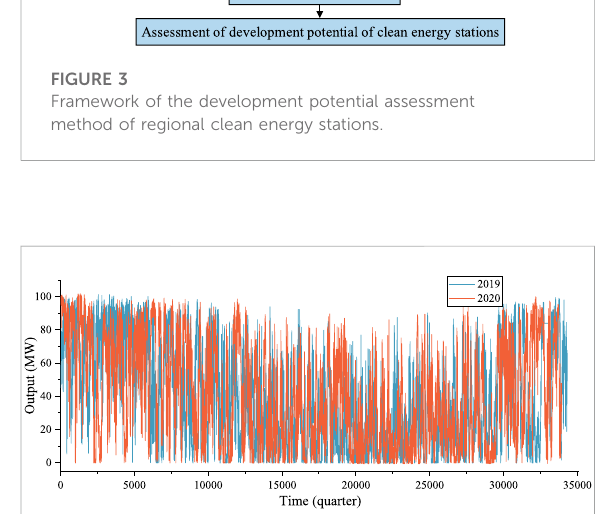
FIGURE 4 Output characteristics of wind station #A in 2019 and 2020.